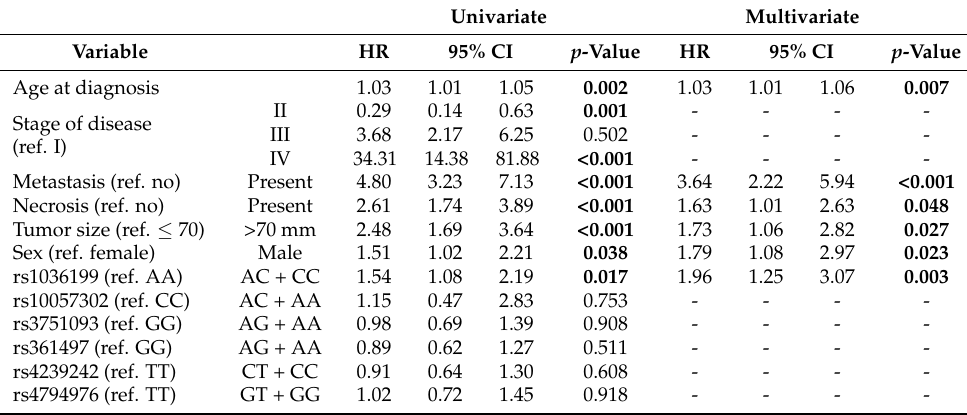
Figure 2. Probability of survival in relation to TIM-3 and LGALS9 gene polymorphisms: ( A ) rs1036199 ( TIM-3 ); ( B ) rs10057302 ( TIM-3 ); ( C ) rs361497 ( LGALS9 ); ( D ) rs4239242 ( LGALS9 ); ( E ) rs4794976 ( LGALS9 ); and ( F ) rs3751093 ( LGALS9 ). n.s. — not significant. Table 5. Univariate and multivariate Cox regression analysis of risk factors’ influences on the mortality of ccRCC